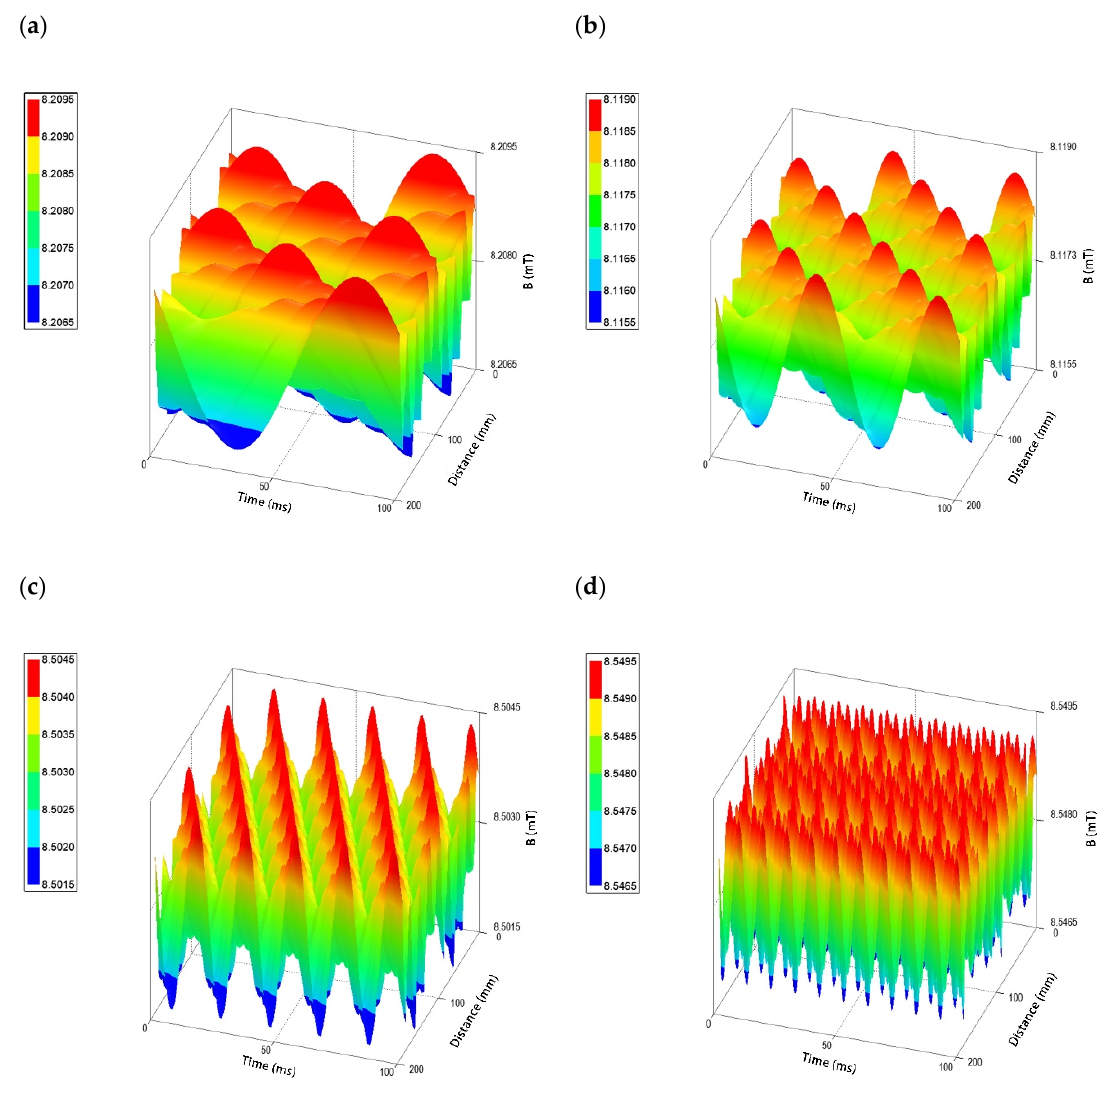
Figure 1. Changes of magnetic flux characteristic depending on the applied AC frequency: ( a ) 5 Hz; ( b ) 10 Hz; ( c ) 25 Hz; ( d ) 50 Hz.